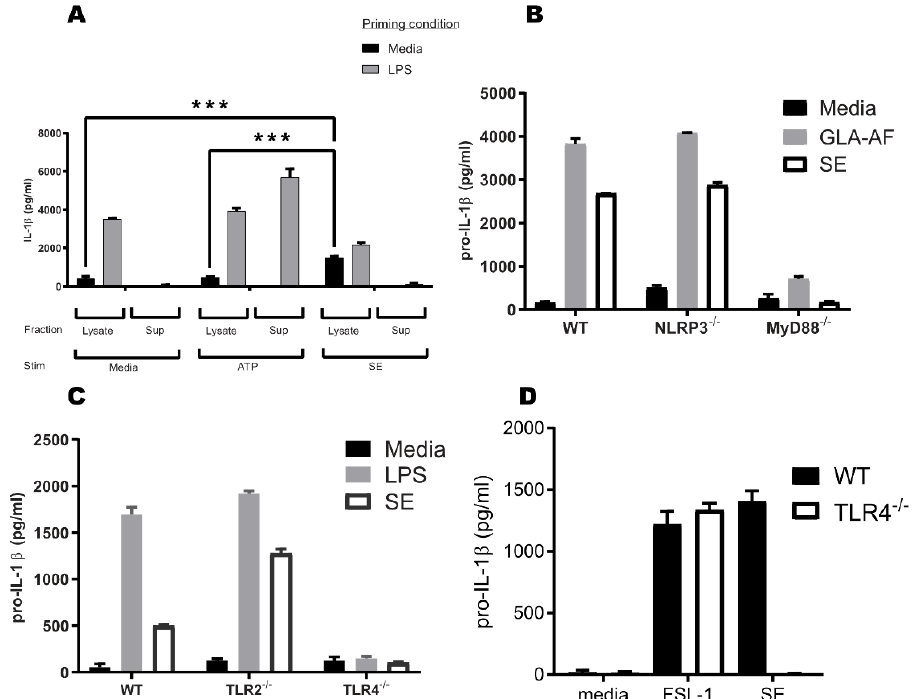
Figure 1. Stable emulsion (SE) elicits pro-IL-1 β production in bone marrow-derived dendritic cells (BMDCs) via a TLR4-dependent process. ( A ) SE stimulates signal 1 of the TLR4 inflammasome path- way in the absence of lipopolysaccharide (LPS). BMDCs from wild-type (WT) mice were primed with media or LPS (10 μg/mL) for 2 h and then stimulated with media, 5 mM ATP, or 0.5% SE. Supernatant (sup) and lysate were collected and assayed for IL- 1β or pro -IL- 1β, respectively, by enzyme-linked immunosorbent assay (ELISA). ( B ) SE stimulates pro-IL- 1β production in a MyD88 - dependent process. BMDCs were derived from WT, NLRP3 −/− , or MyD88 −/− mice and stimulated with media, glucopyranosyl lipid adjuvant-aqueous formulation (GLA-AF) (4 μg/mL), or SE for 5 h. Cells were lysed and assayed for pro-IL- 1β by ELISA. ( C ) SE stimulates IL- 1β production in a TLR4-dependent process. BMDCs were derived from WT, TLR2 −/− , or TLR4 −/− mice and stimulated with media, LPS, or SE for 5 h. Cells were lysed and assayed for pro-IL- 1β by ELISA. ( D ) TLR4 −/− mice are not generally immune deficient. BMDCs were derived from WT or TLR4 −/− mice and stim- ulated with media, FSL-1 (100 μg/mL), or SE. Cells were lysed and assayed for pro-IL- 1β by ELISA. Data are representative of 3–6 experiments with similar results, showing mean ± SEM; statistical significance was determined via one-way ANOVA followed by a Tukey test for multiple compari- sons. *** p < 0.001. 3.2. TLR4 and MyD88 Are Crucial for the Pro-IL- 1β Induction Activity Most TLRs, except TLR3, depend on the MyD88 adaptor protein to effectively link PAMP recognition to changes in gene expression and to mediate signal 1 of inflam- masome activation. Therefore, to understand if SE was specifically interacting with known TLR4 signaling pathways, we employed transgenic MyD88 −/− animals and cell lines as negative controls [37]. Consistent with SE being a canonical TLR4 agonist, pro-IL- 1β expression was ablated in MyD88 −/− BMDCs treated with GLA or SE, whereas the in- flammasome molecule NLRP3 was not required for pro-IL- 1β expression (Figure 1B). To determine which MyD88-associated receptors recognized SE, we examined responses in TLR4- and TLR2-deficient BMDCs. TLR4 −/− , but not TLR2 −/− , BMDCs failed to increase pro- IL- 1β expression in response to SE treatment, indicating that SE acts on the TLR4-MyD88 signaling axis (Figure 1C). Importantly, TLR4 −/− BMDCs produced normal amounts of pro- IL- 1β in response to the TLR2/6 ligand FSL -1, confirming that these cells are not globally defective in pro-IL- 1β expression (Figure 1D). This suggests that some component of SE is stimulating pro-IL- 1β production specifically via a TLR4 and MyD88 -mediated process.